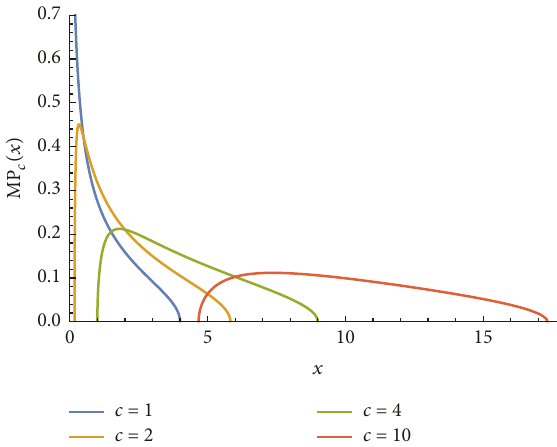
Figure 1: The density of the Marˇcenko-Pastur distributions MP 𝑐 for different values of the parameter 𝑐